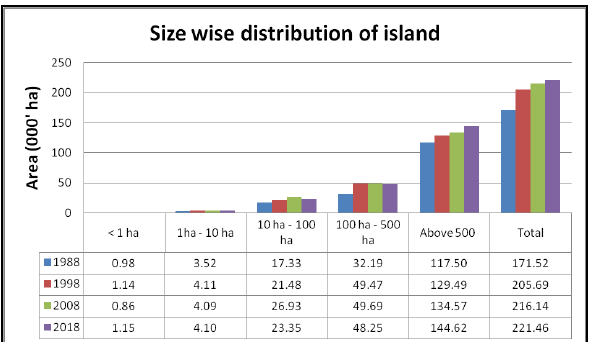
Figure 4. Size wise distribution of Brahmaputra river islands